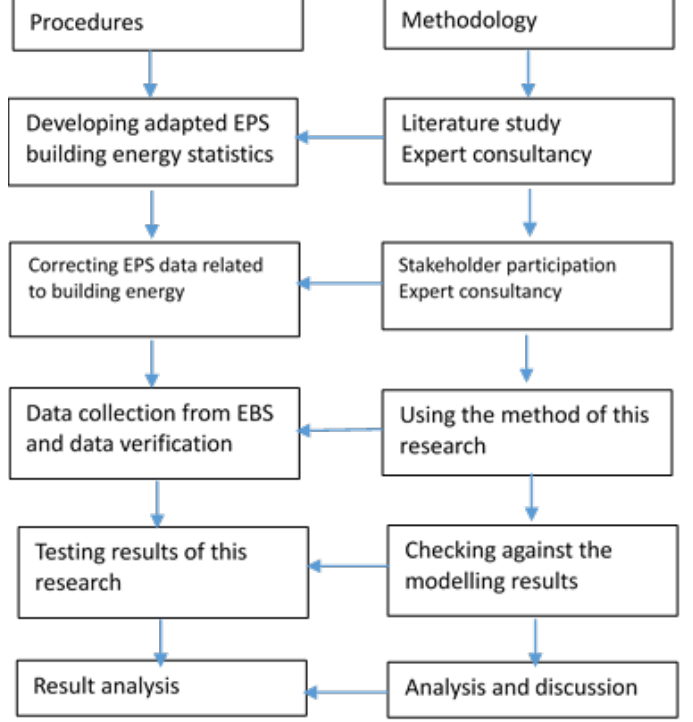
Figure 1. Procedures and methods of this research.